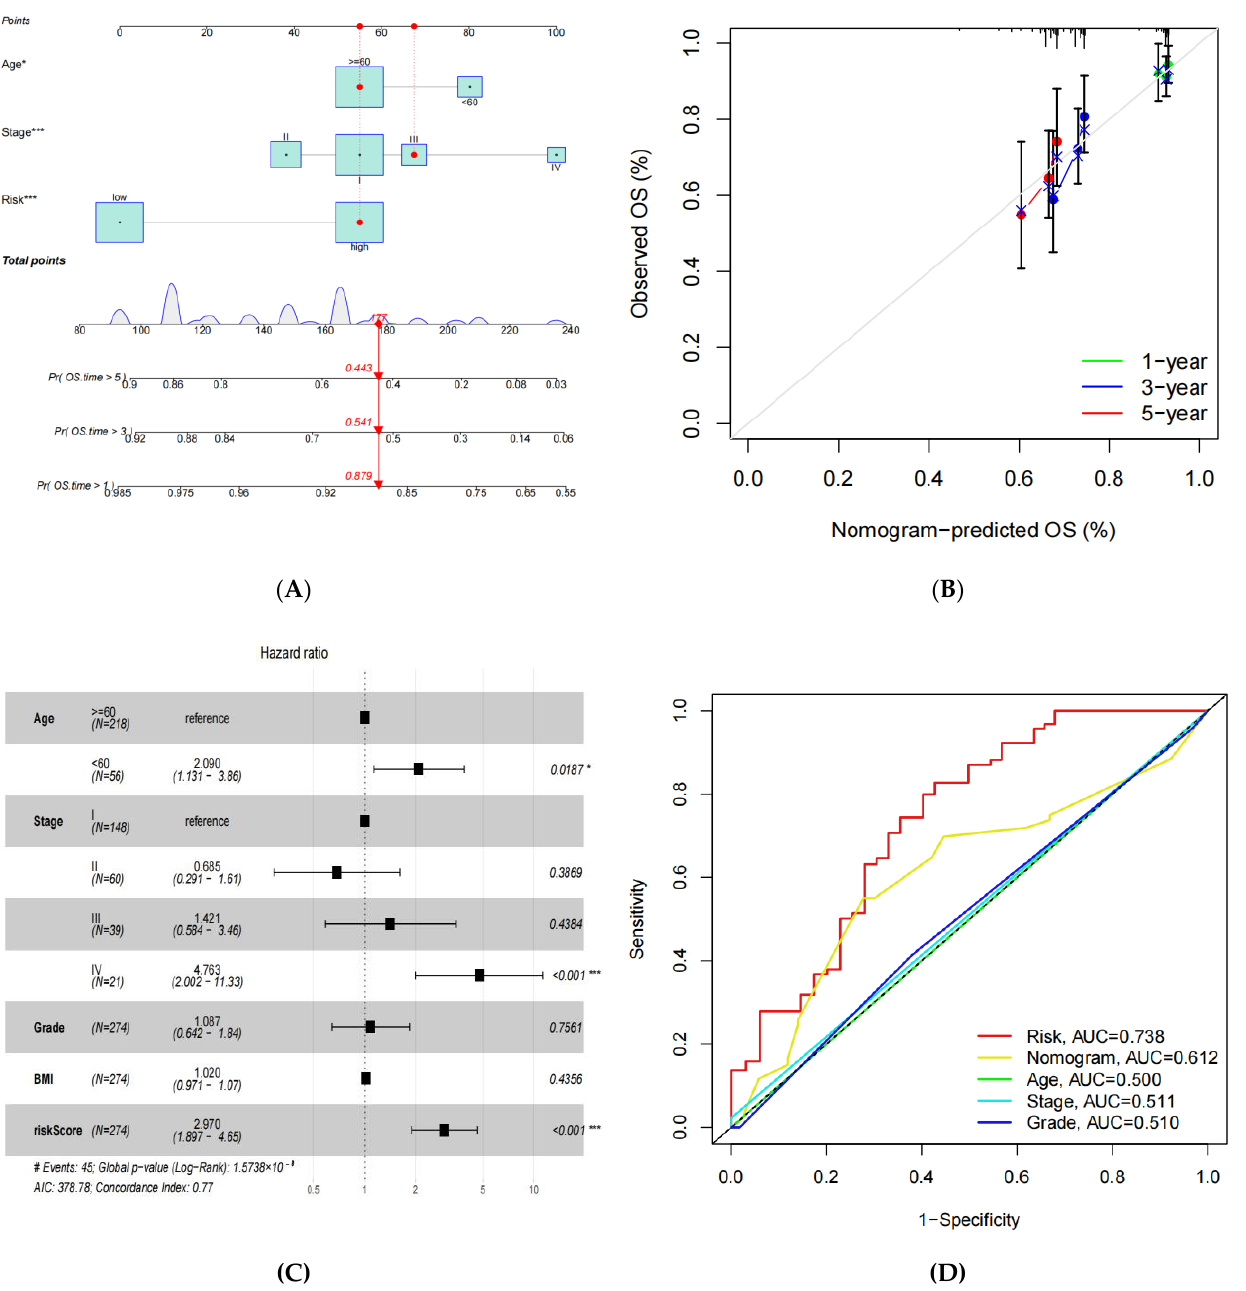
Figure 4. Establishing a nomogram for CESC to predict overall survival rates. ( A ) The nomogram is based on clinicopathological factors and the risk scores. ( B ) Calibration plot of the prognostic model for overall survival (OS) years 1, 3, and 5. ( C ) Multivariate Cox regression model analysis, which included the clinical traits and the risk scores in the TCGA-CESC cohort. ( D ) Multi-index ROC curve analysis of the risk scores and clinicopathological factors. * p < 0.05, ** p < 0.01, and *** p < 0.001.